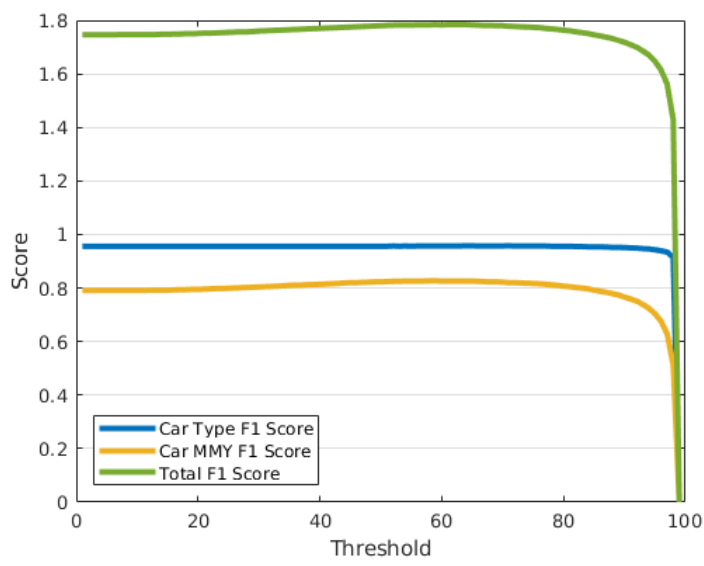
Figure 8. Chart of the singles and total F1 scores obtained with different threshold levels. The tested integer threshold values ranges from 0 to 100 with step 1. The highest value F1 score is 1.784 and occurs with threshold value